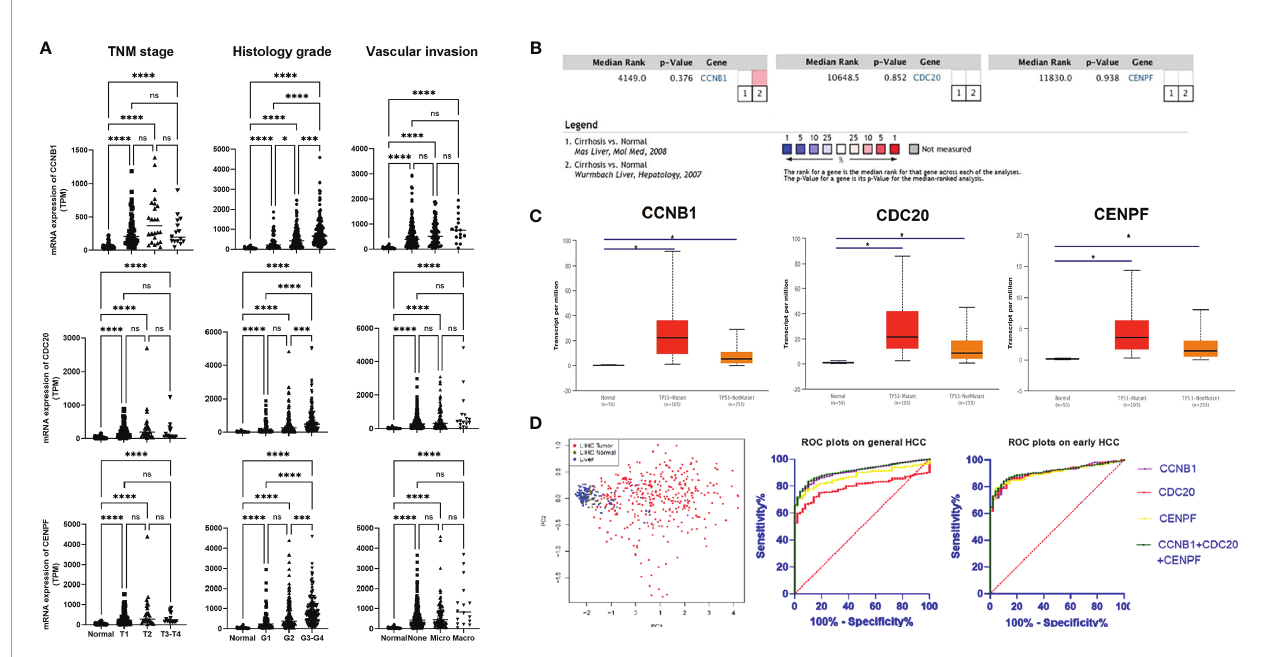
FIGURE 2 | Expression of three core genes across HCC and normal liver tissue: (A) Expression of three genes in HCC tumor tissue based on tumor stage, tumor grade, and other classi fi cations. (B) Meta-analysis on the expression of three genes in liver tissue based on whether they have cirrhosis or not. (C) Expression of three genes in HCC based on whether they have the p53 mutation or not. (D) Validation of diagnostic role of three genes using PCA and ROC analysis. Gene expression pro fi les were downloaded from TCGA database. * P < 0.05, *** P < 0.001, **** P < 0.0001. ns, no signi fi